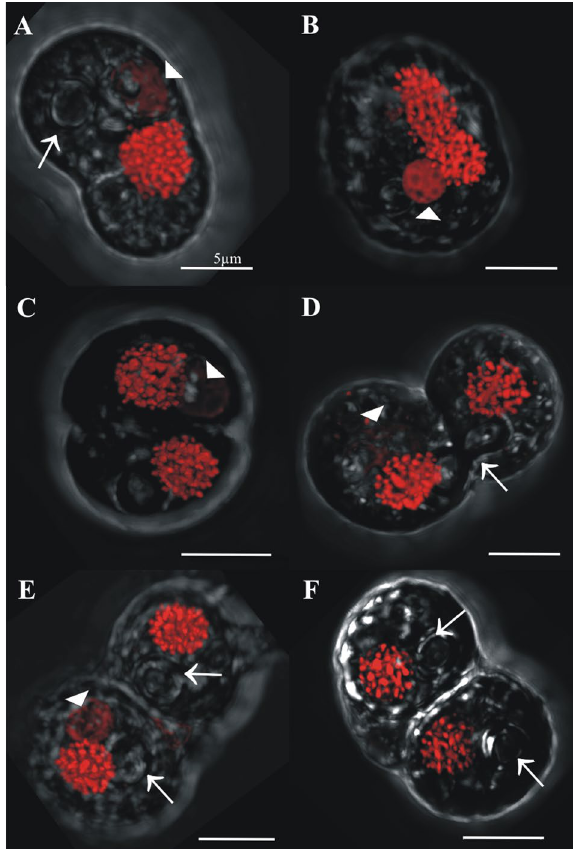
Figure 5. Confocal images of cells sorted in the 2C DNA content gate and classified as part of the mitotic cycle. Arrows denote the pyrenoids and arrowheads denote the accumulation bodies. In these mitotic cells, only one accumulation body/pyrenoid is detected both in single nucleus cells ( A , B ) and in pairs which have already duplicated nuclei ( C ). The pyrenoid is shared in advanced mitotic stages ( B ) and is duplicated only during more advanced mitotic phases ( D – F